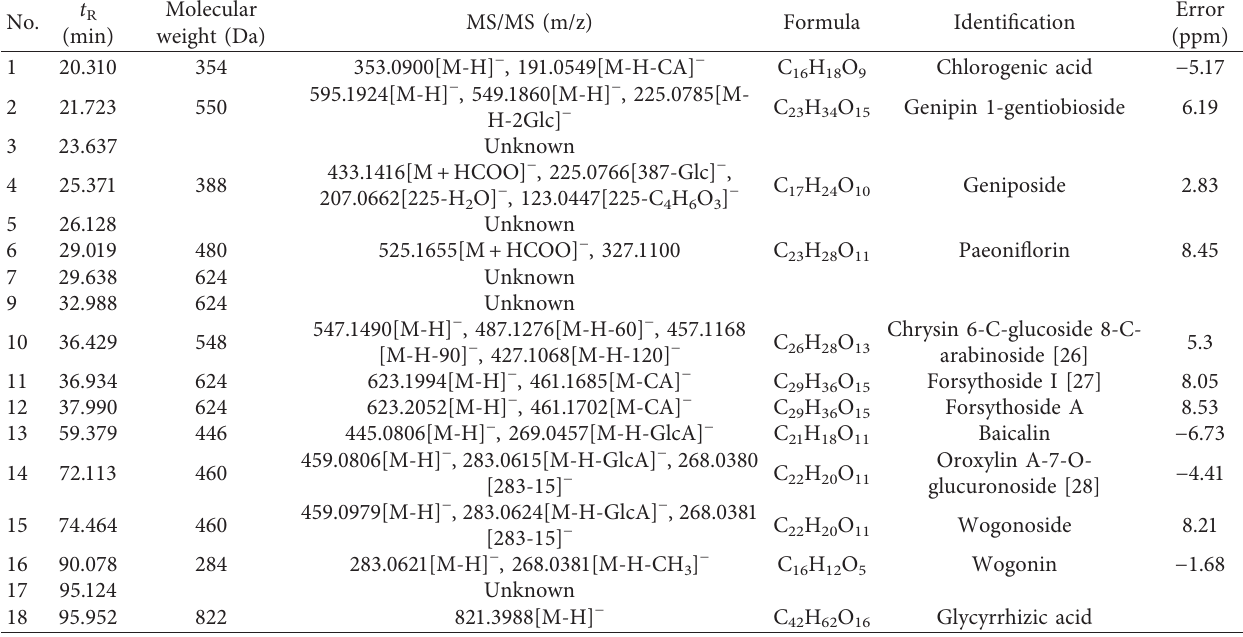
Table 2: Identification of 18 common markers from the HPLC fingerprint of XCQG by HPLC-Q/TOF-MS.